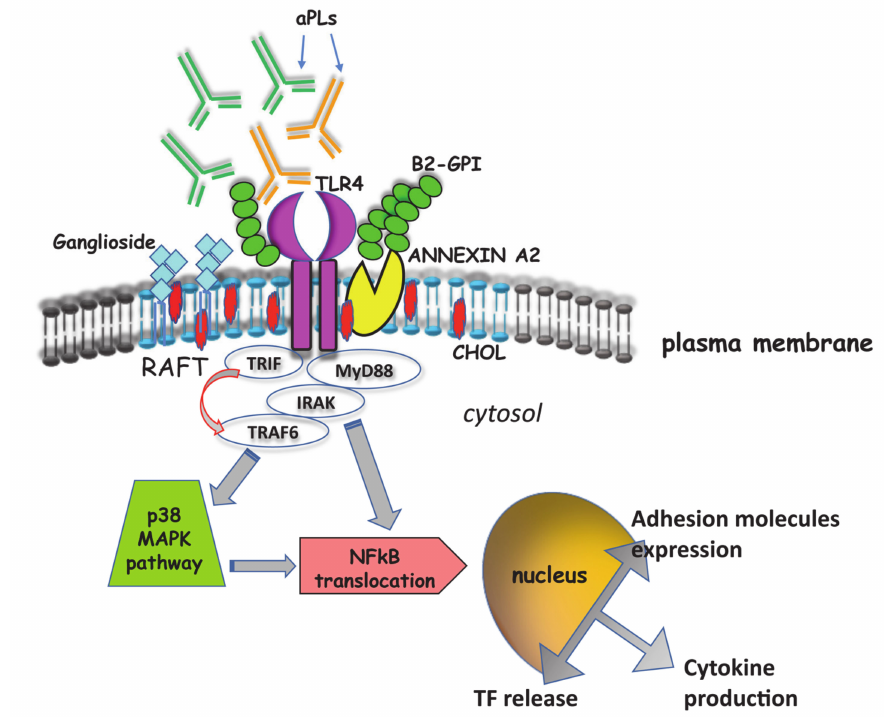
Figure 2. Signaling pathway induced by aPL. Schematic drawing depicting the signaling transduction pathways triggered by aPL via TLR-4, through lipid rafts. This pathway leads to NF- κ B activation and translocation to the nucleus, with an increase of proinflammatory cytokines and chemokines production, adhesion molecules expression and tissue factor